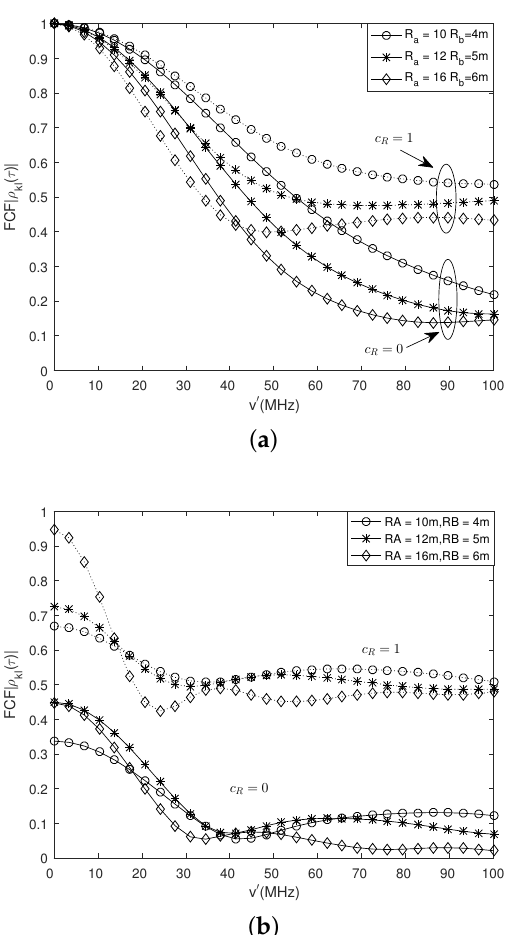
Figure 9. FCF of SET and without ceiling for tunnel parameters for LoS and NLoS. ( a ) FCF of SET. ( b ) FCF of SET without ceiling.